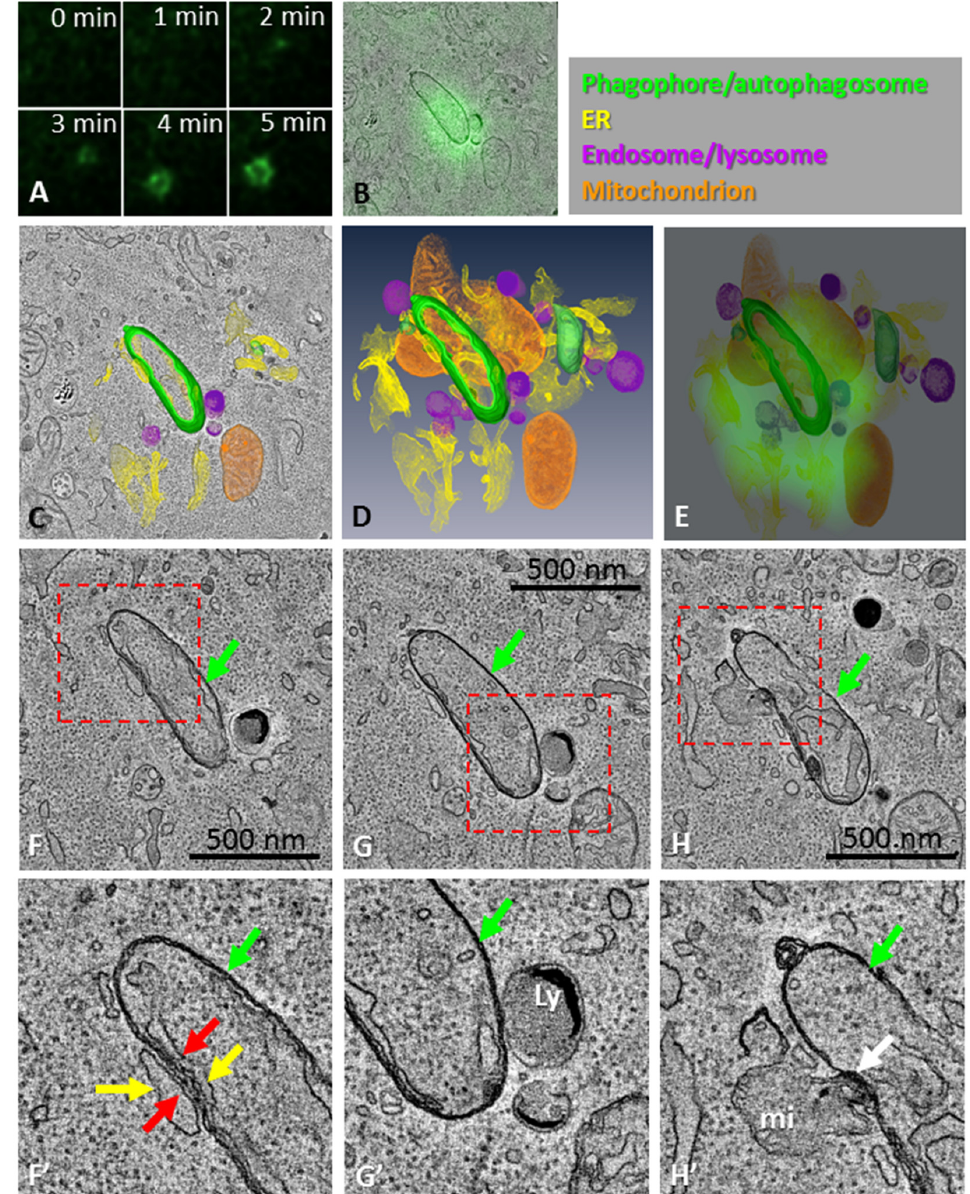
Figure 1. CLEM of an omegasome and a nascent phagophore/autophagosome. ( A ) HEK293 cells expressing GFP-tagged DFCP1 were time-lapse imaged to trace omegasomes. After fixation, the same cell and omegasome were imaged with electron tomography. ( B ) One slice of the tomogram overlaid with the DFCP1 fluorescence. ( C ) The phagophore, ER, lysosomes and mitochondria were traced to create a 3D model, using the color code shown in the top right corner of the figure. Panel ( C ) shows one tomography slice overlayed with part of the 3D model. ( D ) The 3D model shows the relationships of the phagophore, ER, mitochondria and lysosomes with each other. ( E ) The DFCP1 fluorescence from live-cell imaging overlaid with the 3D model. Note that the DFCP1 localization overlaps the ER in the 3D model. ( F – H ) Slices through the tomogram. Panels ( F’ – H’ ) show the boxed areas at higher magnification. ( F , F’ ) The phagophore/autophagosome (green arrows) has MCSs (red arrows in ( F’ )) with the ER (yellow arrows) inside and outside of the phagophore. ( G , G’ ) The phagophore/autophagosome (green arrows) has MCSs with a lysosome (Ly). ( H , H’ ) The phagophore/autophagosome (green arrows) also has an MCS (white arrow in ( H’ )) with a mito- chondrion (mi). In panels ( D , E ), ER, mitochondria and lysosomes are shown as volume rendered according to their grey-level values. See also Supplementary Figure